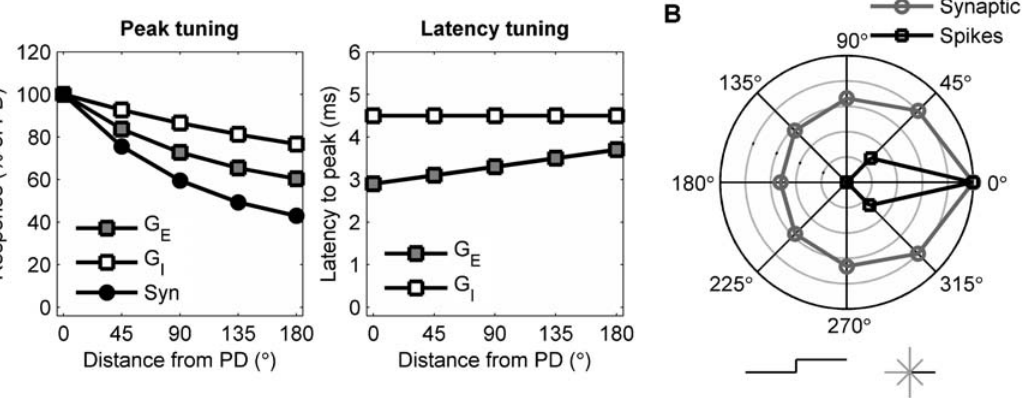
Figure 1. Definition of directionally selective model neuron. A: Latency tuning: directional dependence of excitatory and inhibitory synaptic conductance peaks (left) and latencies (right). Symbols: Gray squares, excitatory conductance; white squares, inhibitory conductance; black circles, total synaptic conductance. B: Polar plot of directional selectivity of model neuron tested with discrete single deflections in one of eight possible directions (symbolically represented at bottom: solid line is 0 u deflection). Responses are on a radial scale normalized to the preferred direction (PD, set to 0 u ) response (outer circle=1). Symbols: Circles, gray line: synaptic responses (mean peak evoked synaptic potential per deflection). Squares, black line: spiking responses (mean evoked number of spikes per deflection, counted over a 20 ms